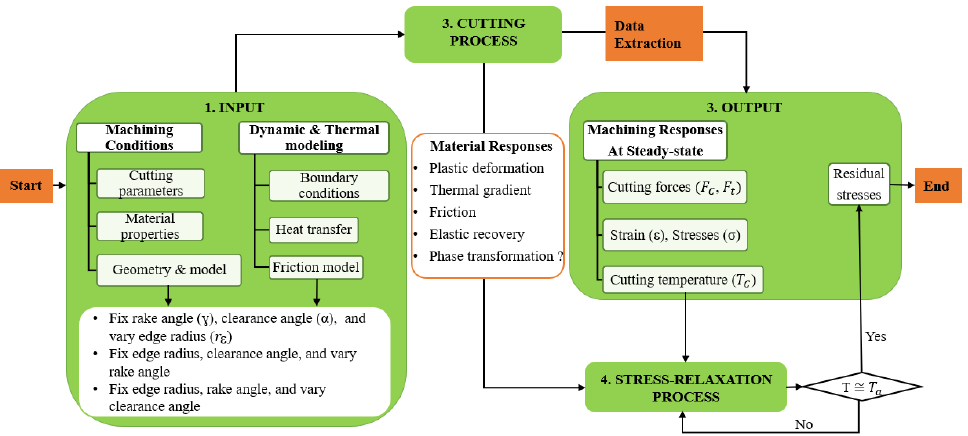
Figure 1. Residual stresses extraction steps.